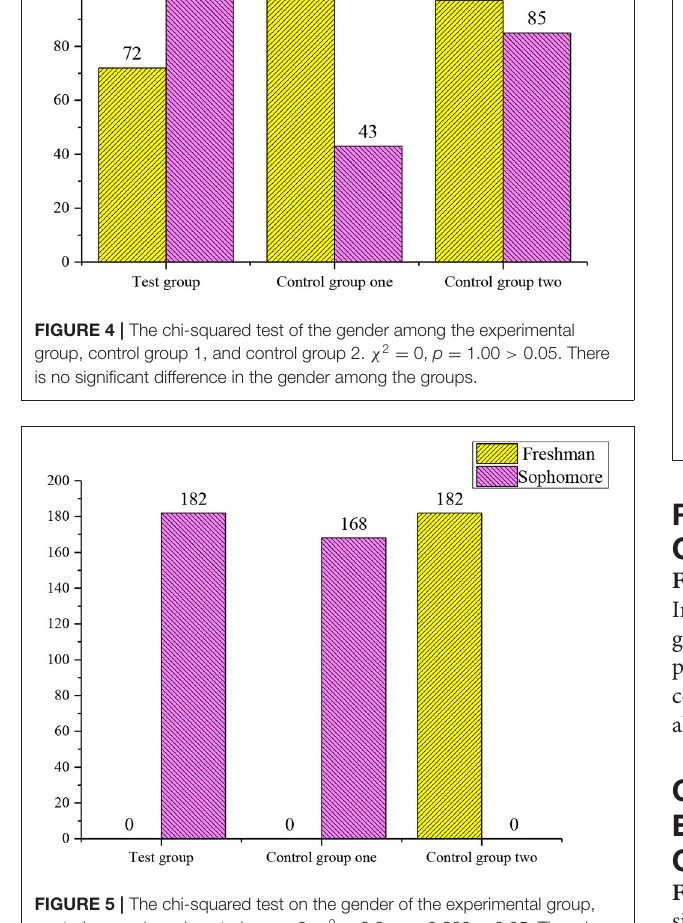
FIGURE 5 | The chi-squared test on the gender of the experimental group, control group 1, and control group 2. χ 2 = 0.3, p = 0.233 > 0.05. There is no significant difference in the grade variables among the three groups.